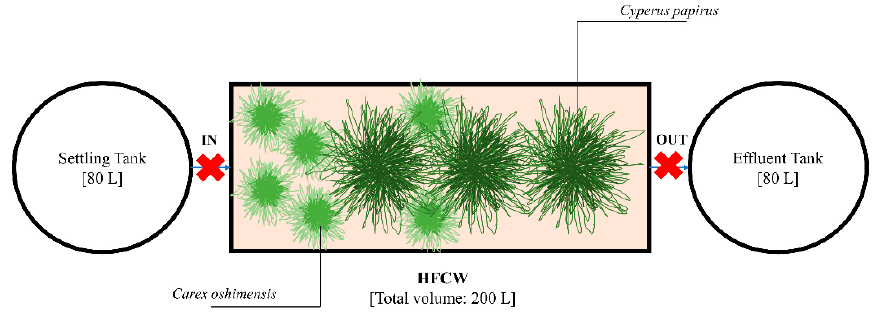
Figure 2. Schematic drawing of the pilot-scale plant. The red crosses indicate the sampling points. HFCW: Horizontal flow constructed wetland.